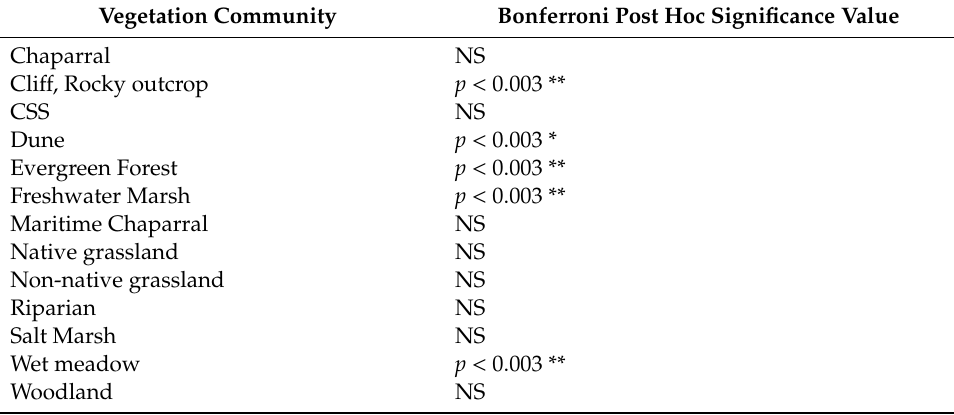
n = 4425, Degrees of Freedom = 13, χ 2 = 2057.56, p Value <